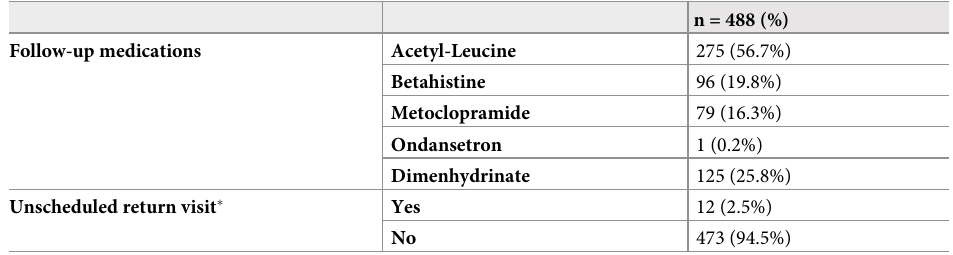
Table 4. Discharge medications and unscheduled return visits of discharged patients.